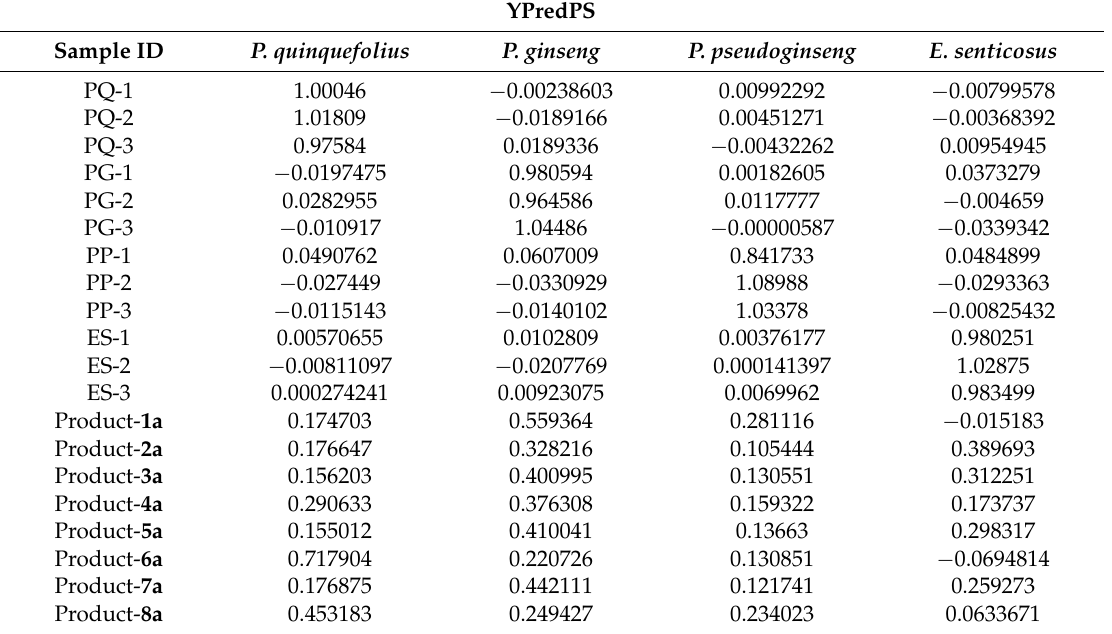
Table 5. Classification list showing predicted Y-values (YPredPS) for both the work set (reference materials) and prediction set (commercial products) based on the OPLS-DA model developed using UHPLC-MS